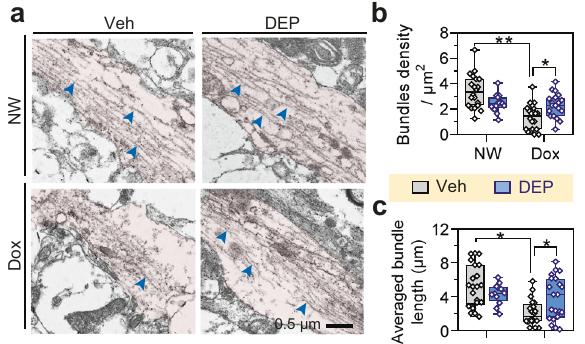
Fig. 5 DEPTAC improves microtubule assembly in dox-treated Tau368 mice. a Representative electron microscopy images. Pink areas indicated the neurites of hippocampal neurons, and the blue arrowheads indicate the representative polymerized microtubules. Scale bar, 500 nm. b , c Dox for 2 months decreased the density ( b ) and length ( c ) of microtubule bundles in Tau368 mice, while both of which were signi fi cantly reversed by 1-month DEPTAC treatment after stopping the dox. Two-way ANOVA followed by Tukey ’ s multiple comparisons tests, * p < 0.05, n = 5 mice and 12 – 23 view fi elds (circles) in each group. Data were presented as Min-Median-